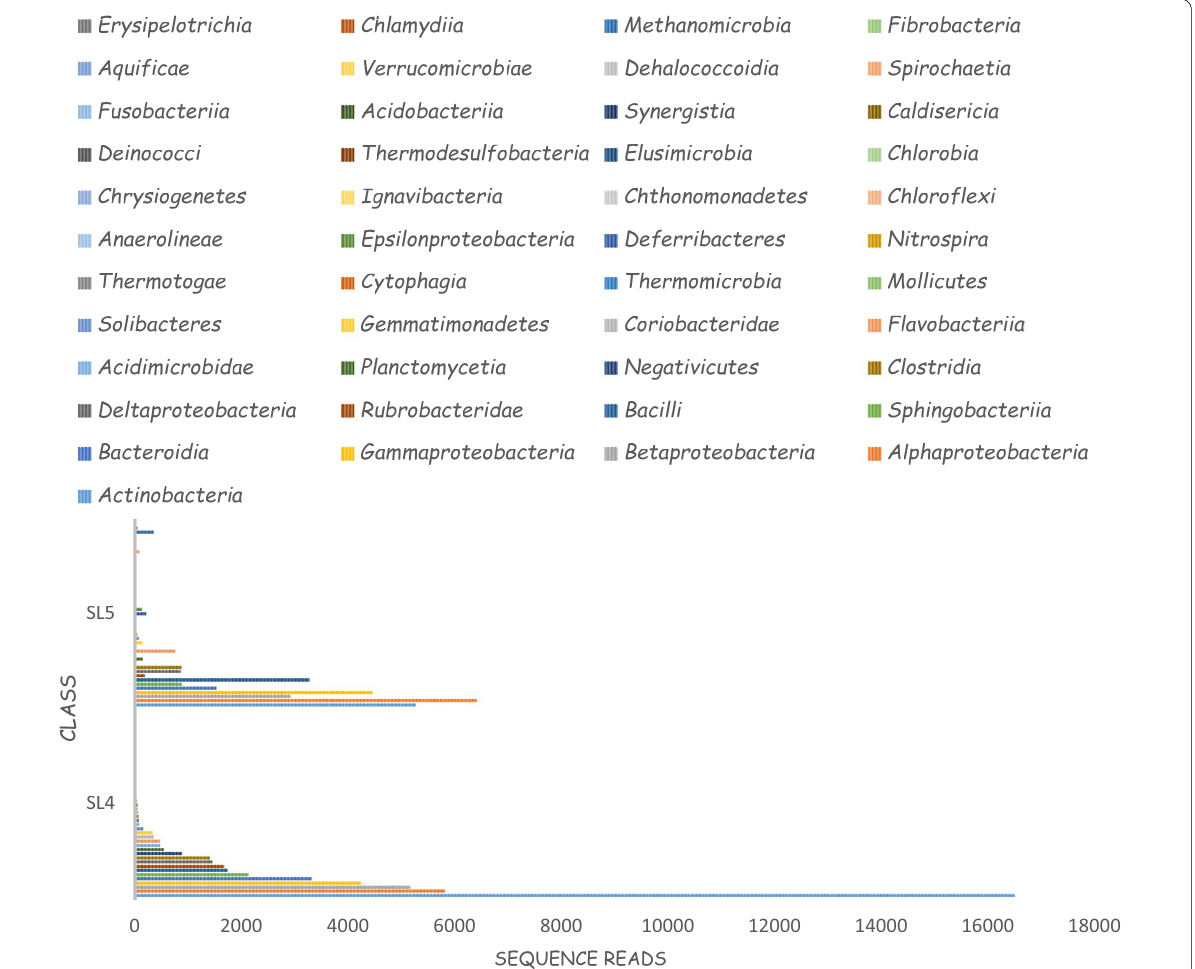
Fig. 2 Comparative taxonomic profile of SL4 and SL5 metagenomes at class level, computed by EDGE Bioinformatics. Unclassified reads were not used for the analysis. All the classes detected in SL4 and SL5 metagenomes were